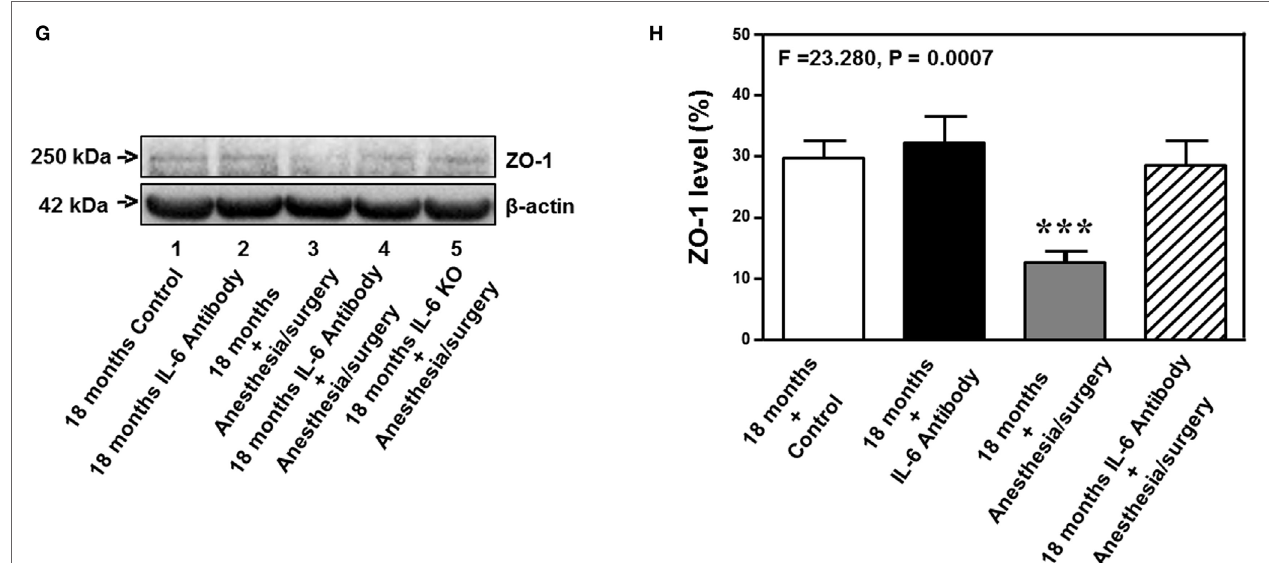
FigUre 8 | IL-6 antibody attenuates the anesthesia/surgery-induced reduction in cell junction proteins. The anesthesia/surgery reduces protein levels of β -catenin (a,B) , claudin (c,D) , occuludin (e,F) , and ZO-1 (g,h) in the hippocampus of 18-month-old mice as compared to control condition at 24 h after the anesthesia/ surgery. Treatment of IL-6 attenuates these reductions in the levels of β -catenin (a,B) , claudin (c,D) , occuludin (e,F) , and ZO-1 (g,h) induced by the anesthesia/ surgery. The knockout of IL-6 gene [lanes 5 in (a,c,e,g) ] also attenuates the anesthesia/surgery-induced reduction in the levels of β -catenin (a) , claudin (c) , occludin (e) , and ZO-1 (g) . IL, interleukin. N = 6 in each group except IL-6 gene knockout group of (a,c,e,g)